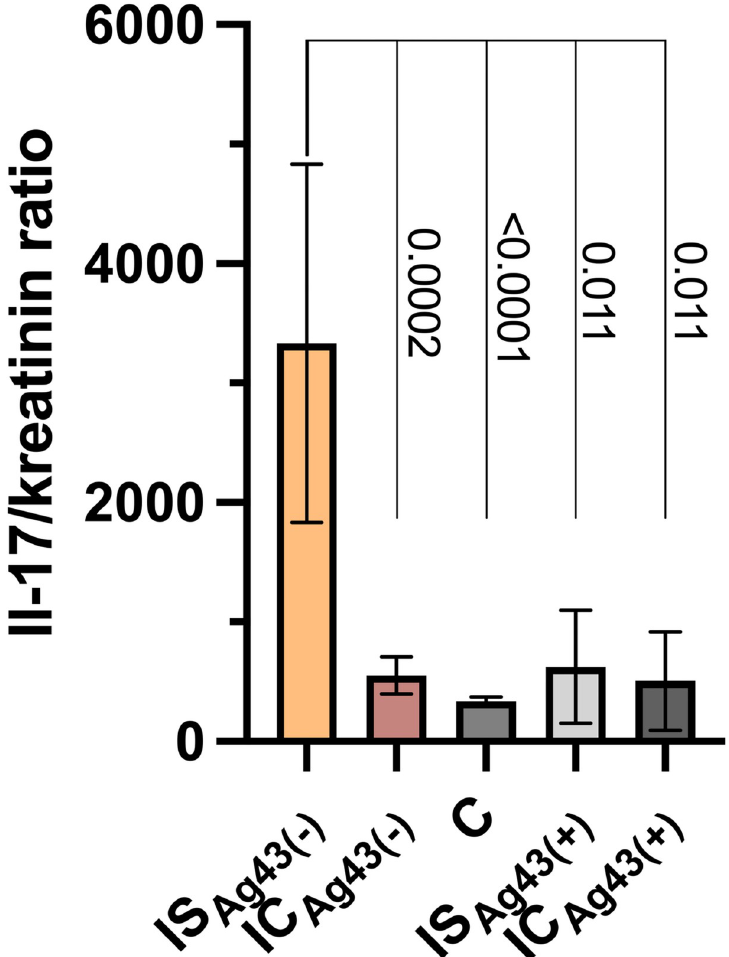
Fig 5. Differences in urine IL17 concentration between kidney recipients (IS), immunocompetent hosts (IC), and controls (C) regarding the presence of Ag43 gene in the isolated UPEC strain. Significantly higher values were observed in urines from kidney recipients infected with Ag43-negative strains. The differences between other groups are not